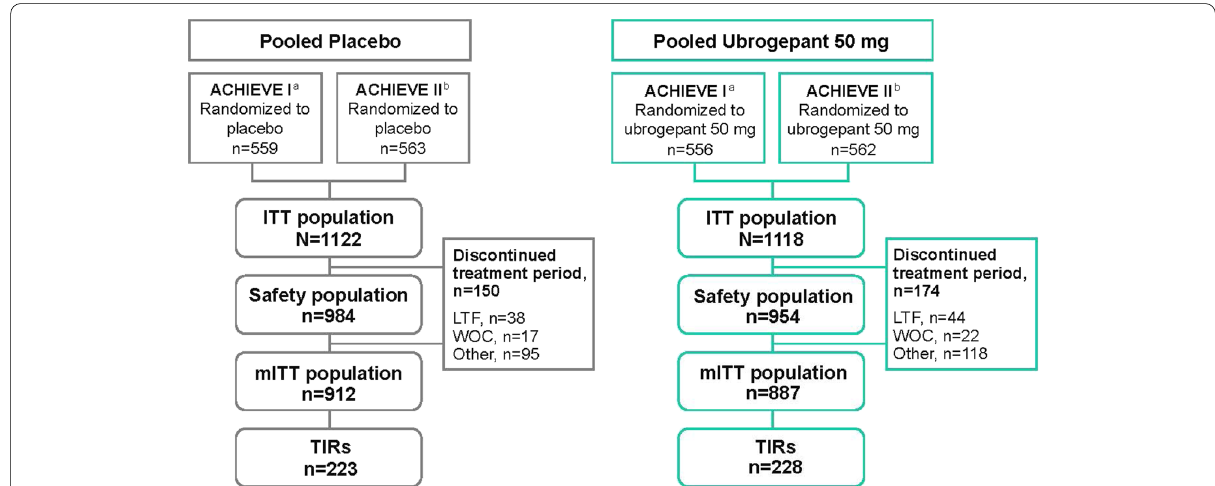
Fig. 1 Participant flow diagram. LTF, lost to follow-up; ITT, intent-to-treat; mITT, modified intent-to-treat; TIR, triptan insufficient responder; WOC, withdrawal of consent. a This analysis did not include the ubrogepant 100 mg arm from the ACHIEVE I trial. b This analysis did not include the ubrogepant 25 mg arm from the ACHIEVE II